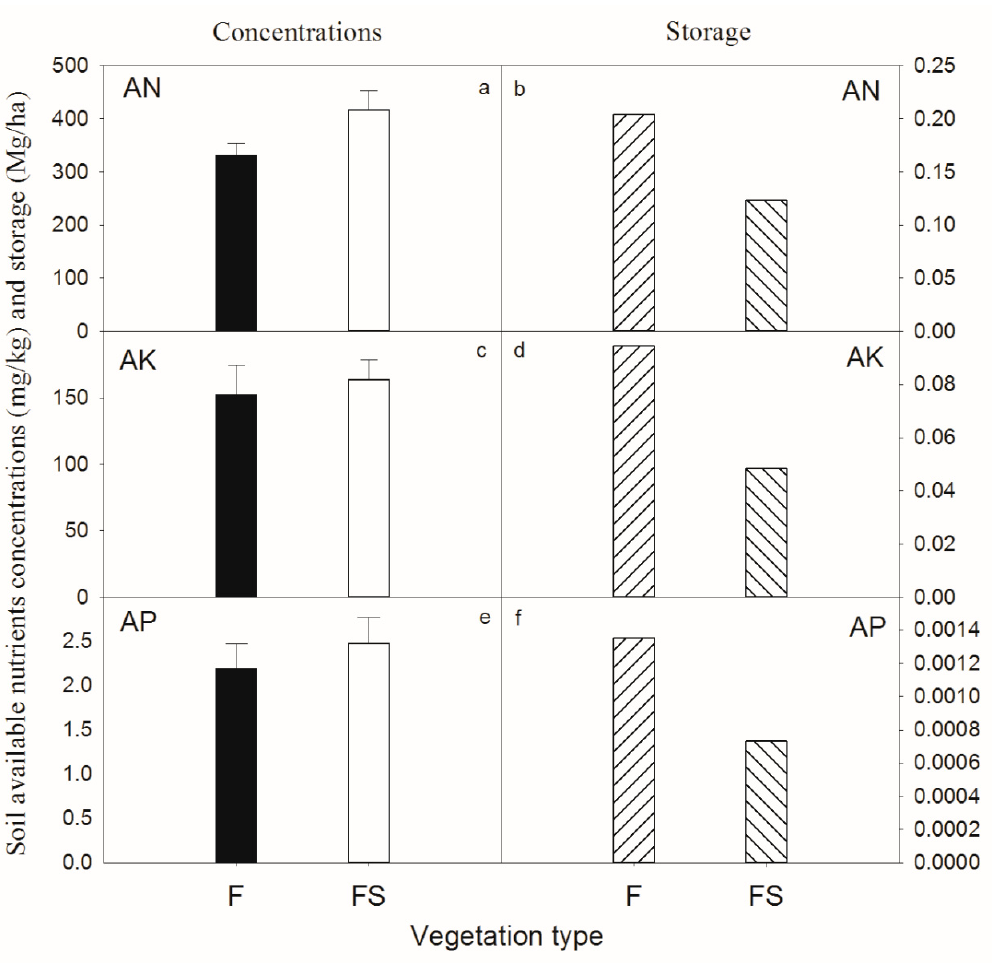
Figure 8. Soil plant-available nutrient concentrations and stocks of two di ff erent vegetation types in southwestern China.